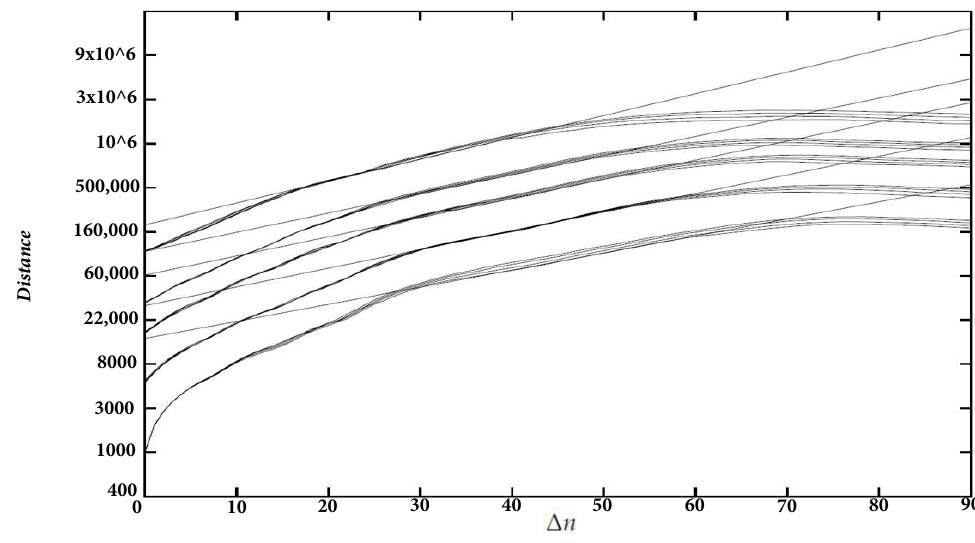
Figure 11. Regression lines for coop1. Table 2. Maximal Lyapunov exponents for coop1.